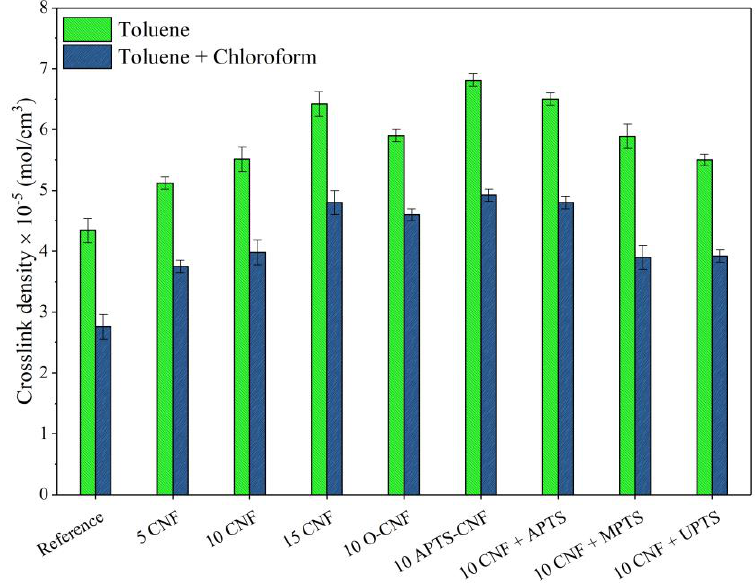
Figure 7. Crosslink density values of the NBR vulcanizates filled with unmodified and chemically treated carbon nanofibers.